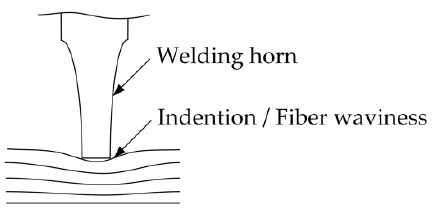
Figure 14. Illustration of a horn locally welding the laminate stack leading to fiber waviness due to uneven pressure distributions.